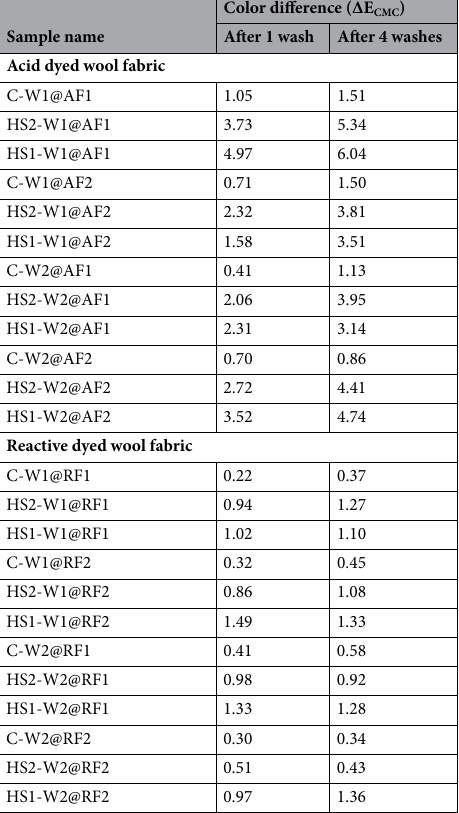
Table 2. Fastness to washing based on color difference (ΔE CMC )